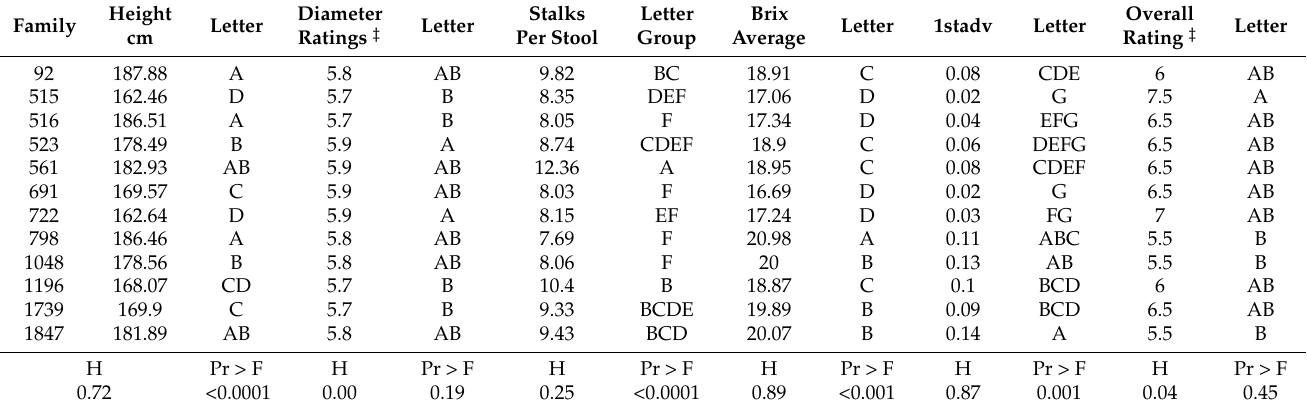
Table 5. Mean significant differences and F values for sugarcane seedling first ratoon height, stool diameter rating stalks per stool, Brix average, first line advancement rates and Overall family